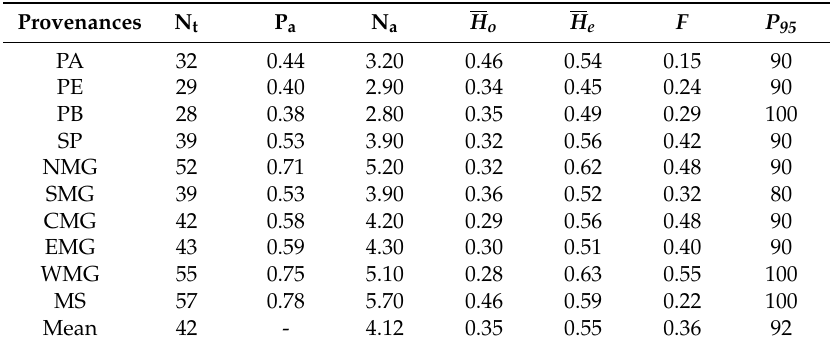
Table 3. Average estimates of genetic diversity parameters for ten Acrocomia aculeata provenances based on ten polymorphic SSR